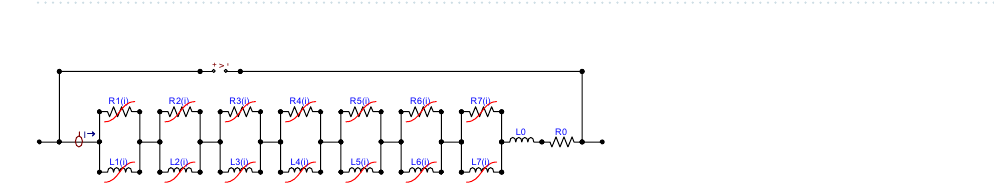
Figure 1. Experimental data from 10 used in this paper for fitting parameters of models: measured Z true (cid:31) f , i DC (cid:30) impedance characteristics for frequency range f = 1kHz ÷ 100MHz and current up to saturation i = 0 ÷ 50A ; solid lines denote absolute values | Z true | (cid:31) f , i DC (cid:30) and dashed lines denote phase angles ϕ true (cid:31) f , i DC (cid:30) ; colors denote bias current i DC according to legend.